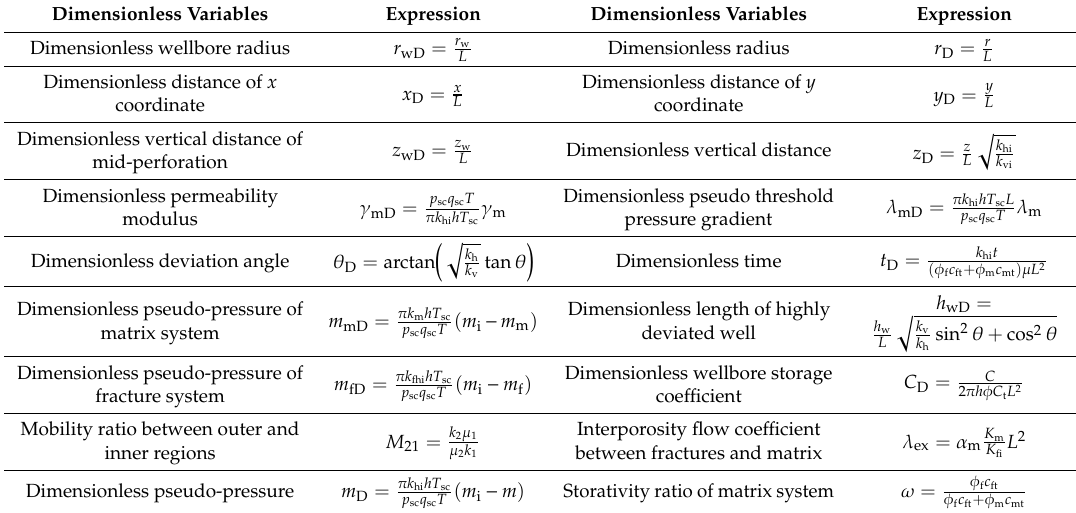
Table A1. Definition of dimensionless